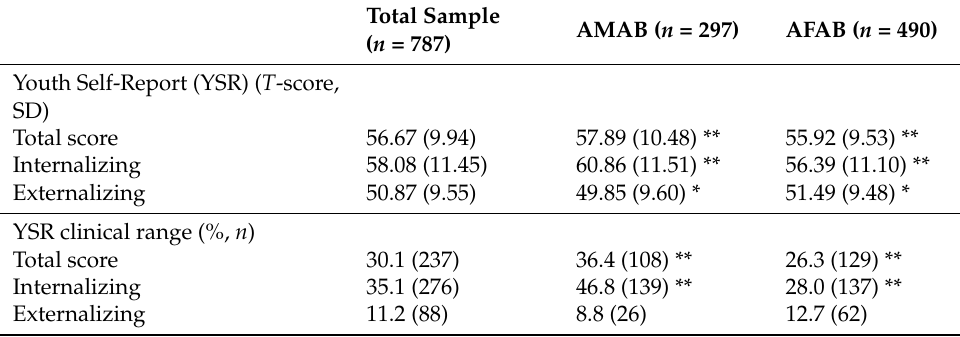
Table 3. Rating of psychological functioning: total sample and separated for birth-assigned sex.